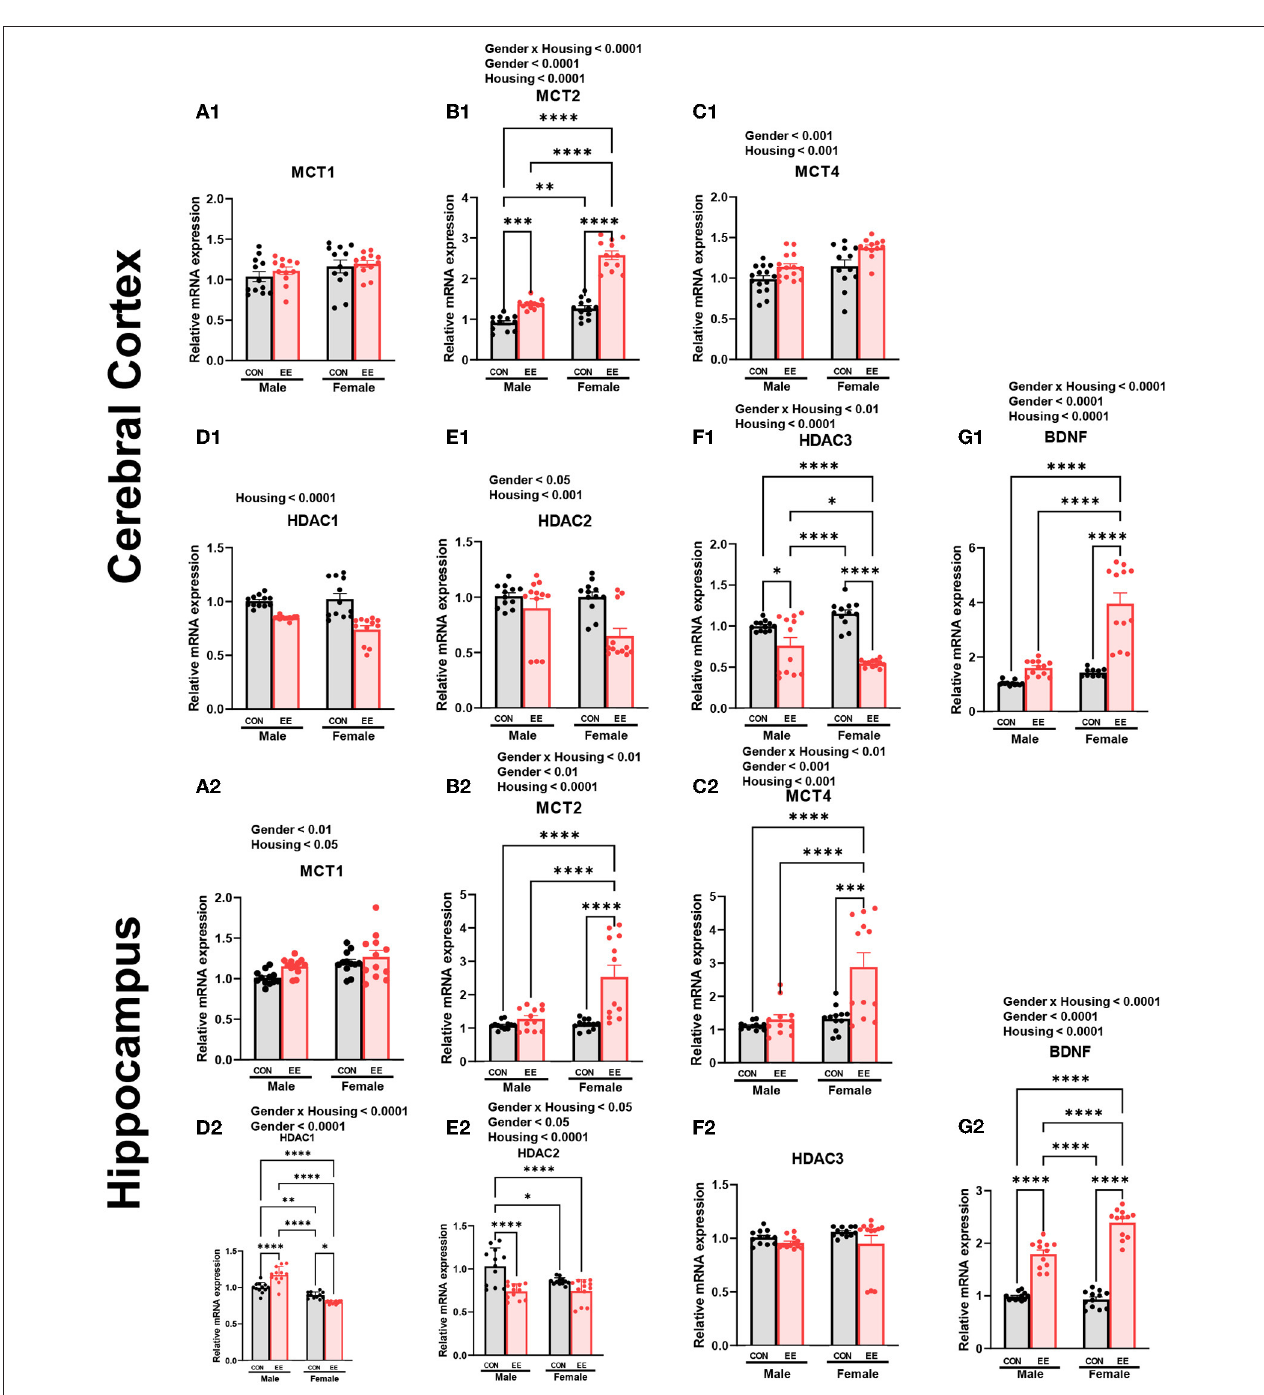
FIGURE 3 | Effects of EE on the expression of β HB-related genes under the influence of estrogen by qRT-PCR. (A1–G1) Cerebral cortex and (A2–G2) hippocampus mRNA levels for β HB-related genes measured using qRT-PCR ( n = 4 per group). All samples were run in triplicate. Two-way ANOVA with Tukey multiple comparison test. Significant sex effect, significant housing effect, and the significant interaction between sex and housing were noted with p -value. Data are means ± SEM. * p < 0.05, ** p < 0.01, *** p < 0.001, and **** p <